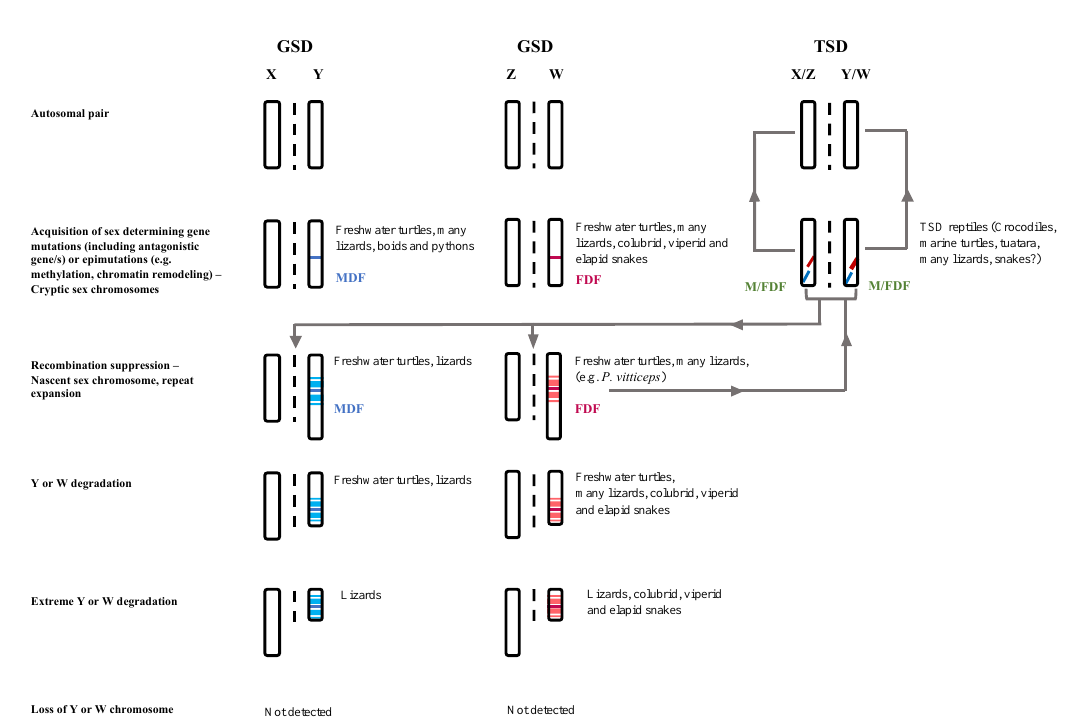
Figure 2. Proposed model for lizard sex chromosome evolution, modified from [11]. Many Reptiles are likely to have followed the currently held view of sex chromosome evolution as proposed for vertebrates but may also involve other regulatory molecular mechanisms (e.g., epigenetic). The sex determination (sensu sex chromosomes) in genotypic sex determination (GSD) and temperature-dependent sex determination (TSD) with environment influence is bipotential and could involve polygenic or epigenetic mechanisms, hence retaining the homomorphic sex chromosomes and high diversities. MDF = Male determining factor, FDF = Female determining factor.